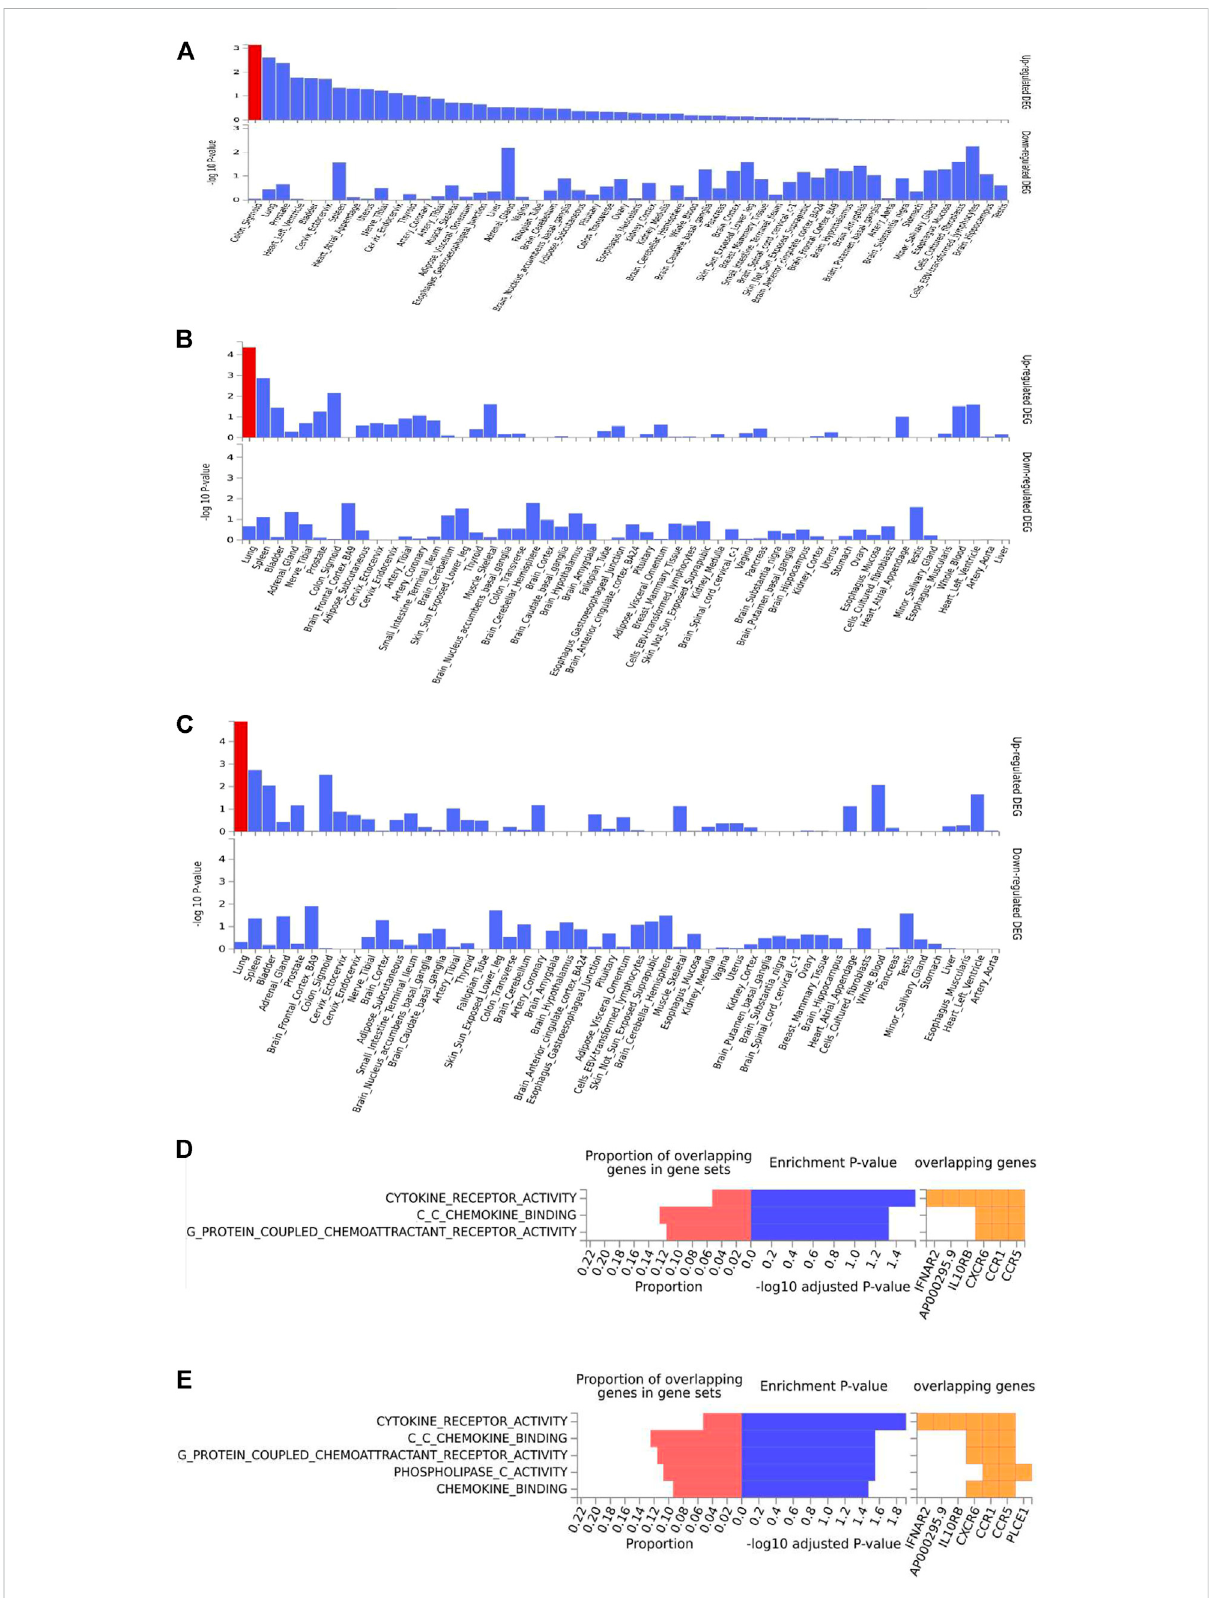
Enrichment analysis of shared genes between hypertension and adverse outcomes of COVID-19, i.e., death, very severe respiration, and hospitalization. (A – C) Tissue enrichment of shared genes between hypertension and COVID-19 death, very severe respiration, and hospitalization, respectively. (D) and (E) GO function enrichment of shared genes between hypertension and COVID-19 very severe respiration and hospitalization,